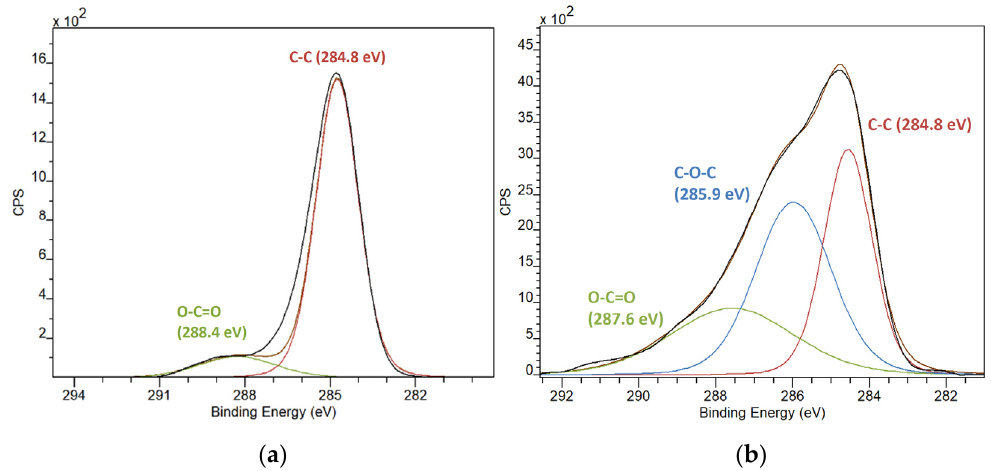
Figure 9. Comparison of high-resolution C 1s spectra of: ( a ) as-deposited AlN sample; ( b ) annealed AlN sample.